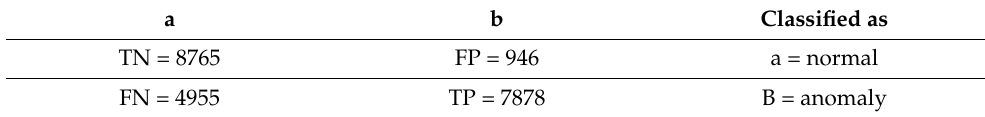
Table 5. SMO parameters measurement.